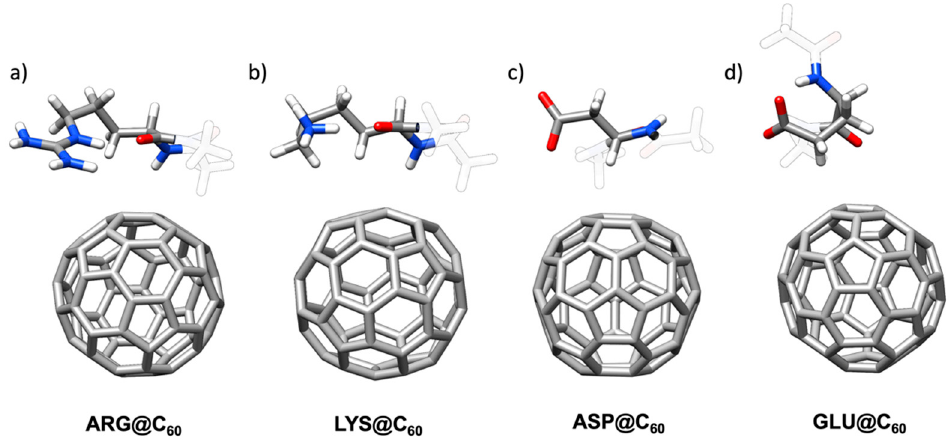
Figure 4. Snapshots from the MD of the interactions of charged amino acids ( a ) Arg, ( b ) Lys, ( c ) Asp and ( d ) Glu with C 60 . For each amino acid, the most interactive configuration is shown.